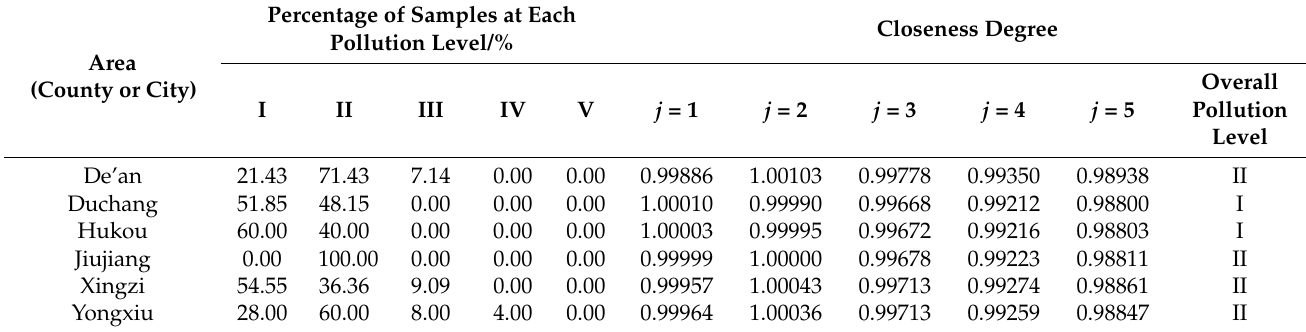
Table 6. Evaluation results of potential toxic elements pollution in cultivated soils across the study region.